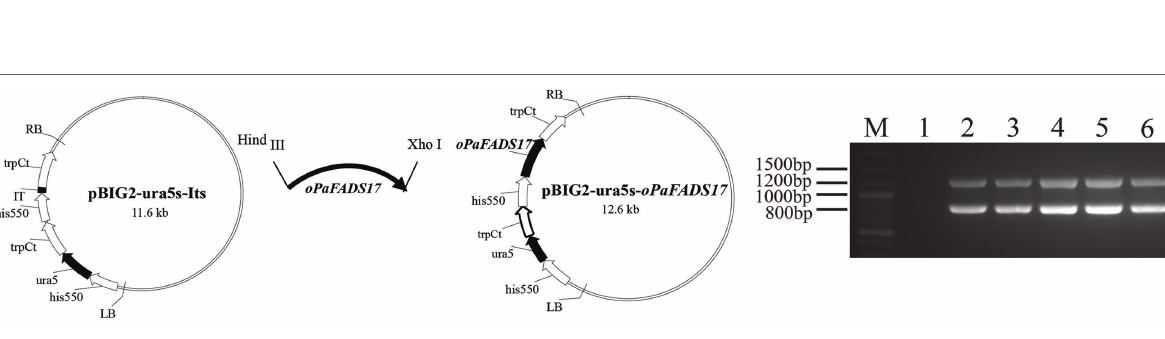
FigUre 4 | The conversion rate of INVSc 1 (pYES2/NT C- oPAD17 ) with exogenous fatty acids supplementation . (a) Is for different fatty acids at different temperatures; (B) is for different arachidonic acid concentration. Conversion rate was calculated as 100% × Product/(Product +